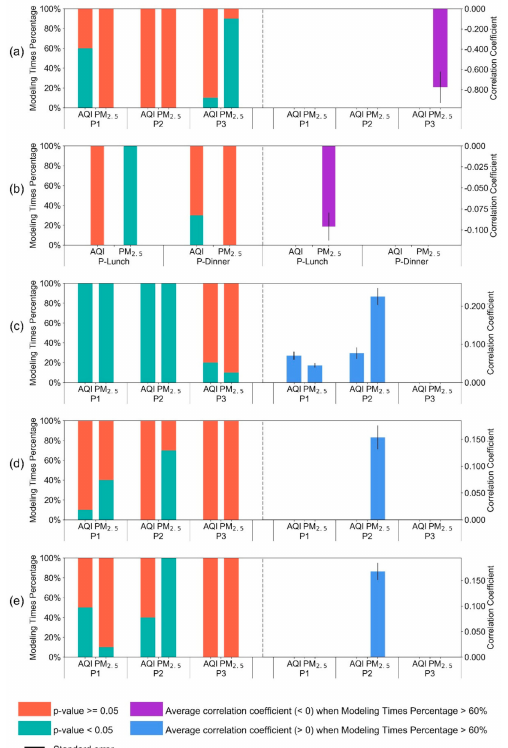
Figure 3. The effects of air pollution on people’s living activities. ( a – c ) are the results of sightseeing, eating out, and the staying-in ADLs, while ( d , e ) represent the use of different transportation modes ADL reflected by the situation at bus stops and subway stations. The bottom green bars in the left of each subplot show the percentage of the probability value ( p -value) that are less than 0.05, which means the corresponding coefficients are significant within a 95% confidence interval among the 10 times they are repeated with different datasets. The red bars to the left of each subplot represent the percentage of the p -value is higher or equal to 0.05, which means there is no obvious relationship between the people’s activity and AQI or PM 2.5 concentrations. We determine that PM 2.5 as part of an AQI influences people’s activity only when the percent of significant coefficient ( p -value < 0.05) is more than 60% (as indicated by a single length of green bar in the left graphs). We plot the mean correlation coefficient value and standard error for every group of experiments to the right of the Figures represented by blue (if the value > 0) and purple (if the value < 0) with the error bars (if it is no more than 60%, we do not plot anything in the right-side graphs). The results are reported in Tables